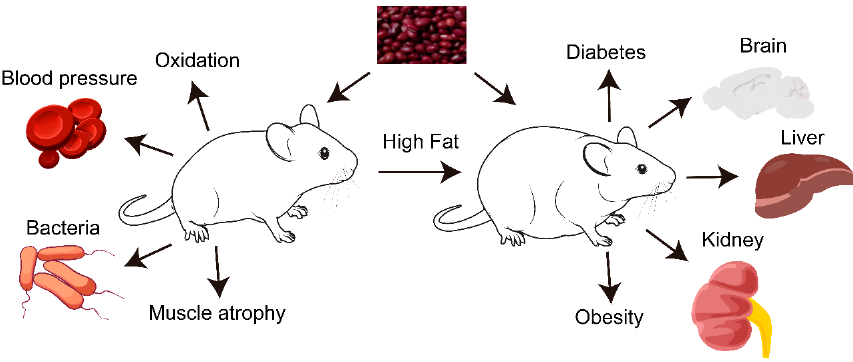
Figure 2. Health benefits of adzuki beans and adzuki bean extract in mice or